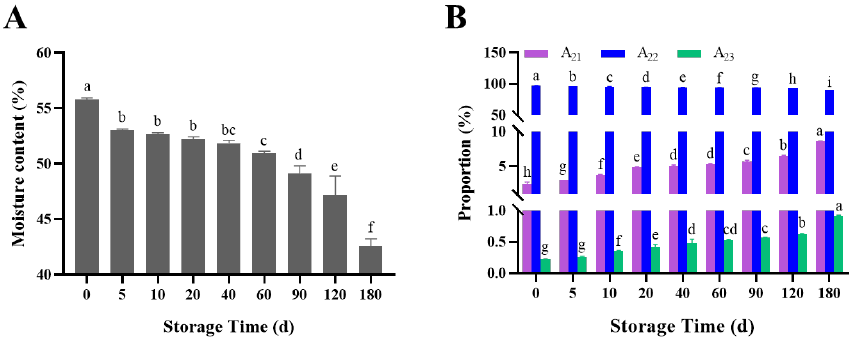
Figure 2. Changes in moisture content ( A ) and distribution ( B ) of semi-dried rice noodles during storage. Different letters within each color bar denote significant difference ( p < 0.05).